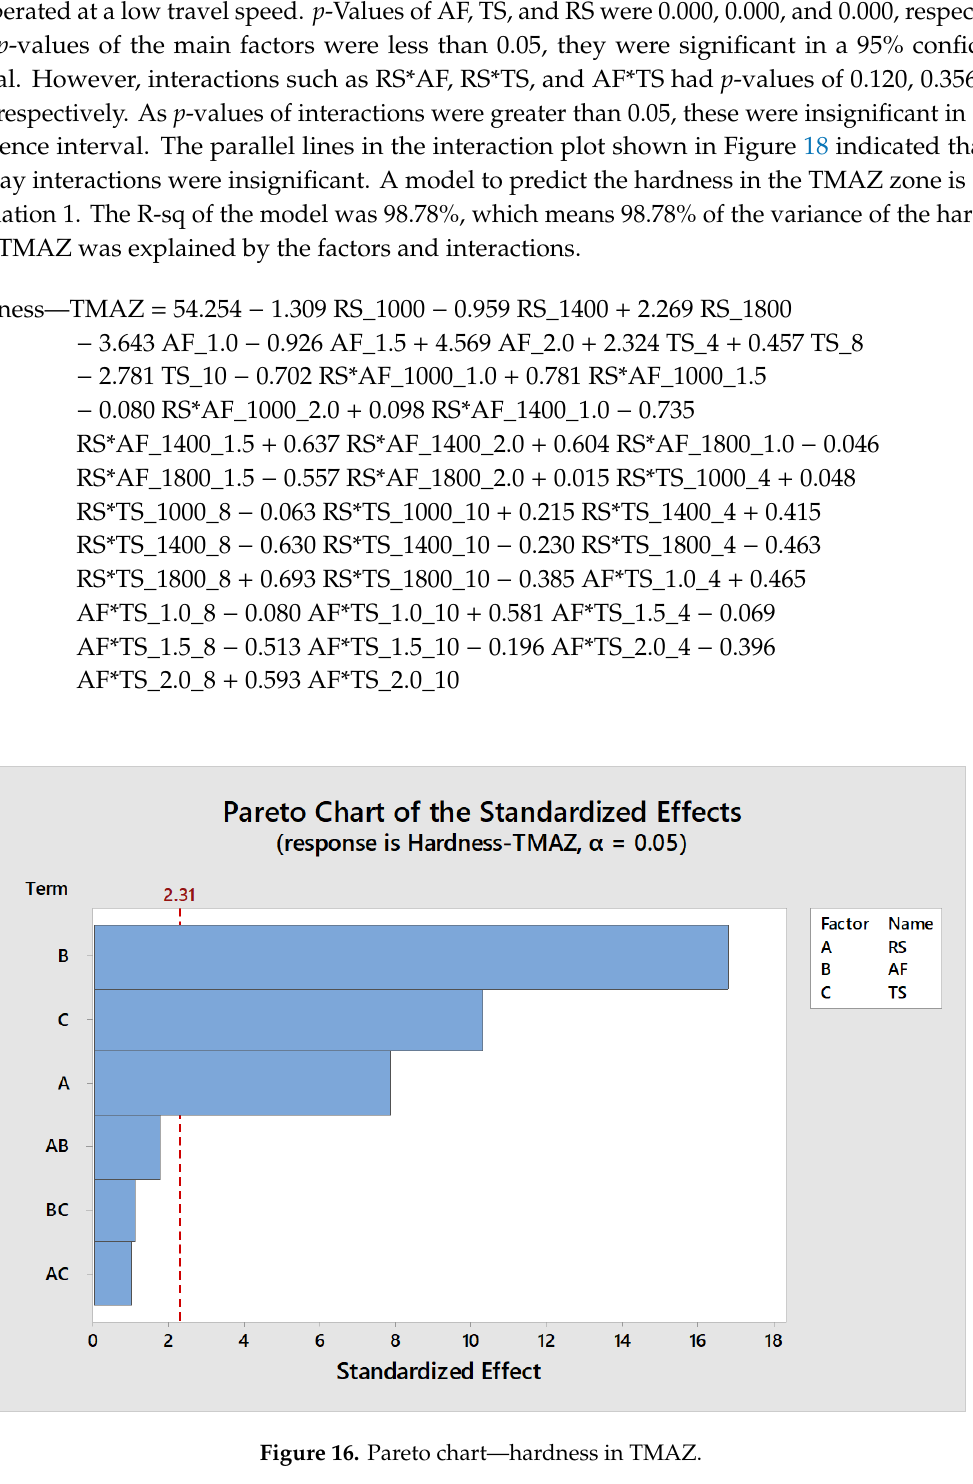
Figure 16. Pareto chart — hardness in TMAZ.